Question: Reading the figure, is the described quantity rising or falling?
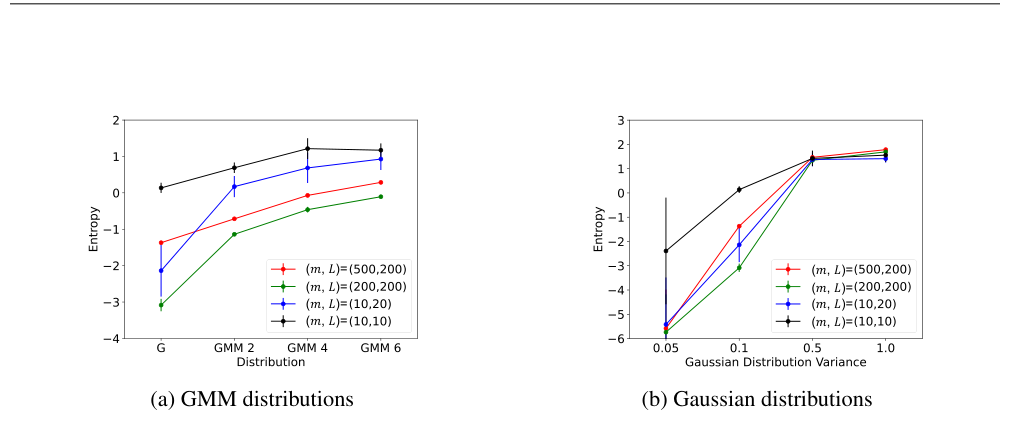
Answer: increasing